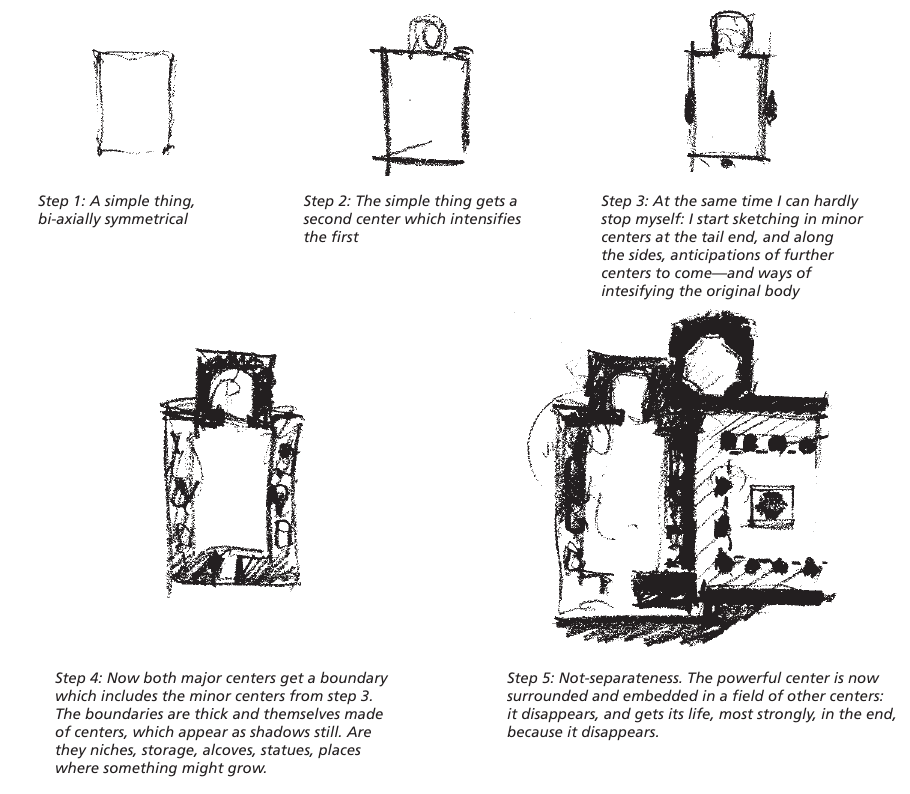
Figure 19. Structure-preserving transformations. Source: { Nature of Order Book Two}